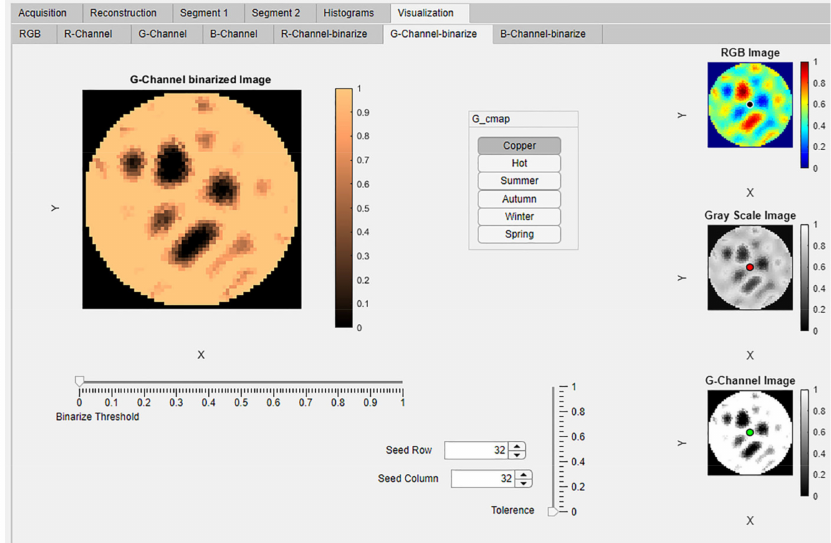
Figure 13. Visualization module: Advanced interactive visualization and segmentation